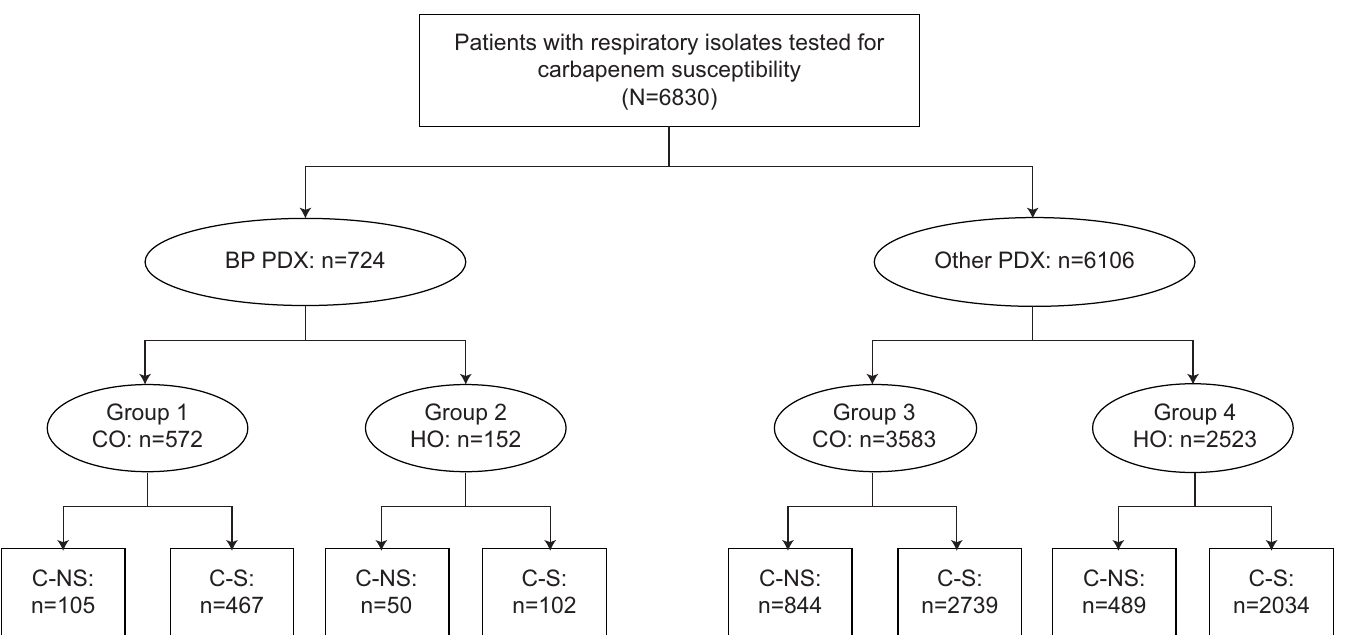
Fig 1. C-NS versus C-S case tree. BP, bacterial pneumonia; C-NS, carbapenem nonsusceptible; C-S, carbapenem susceptible; CO, community-onset; HO, hospital- onset; PDX, principal diagnosis.